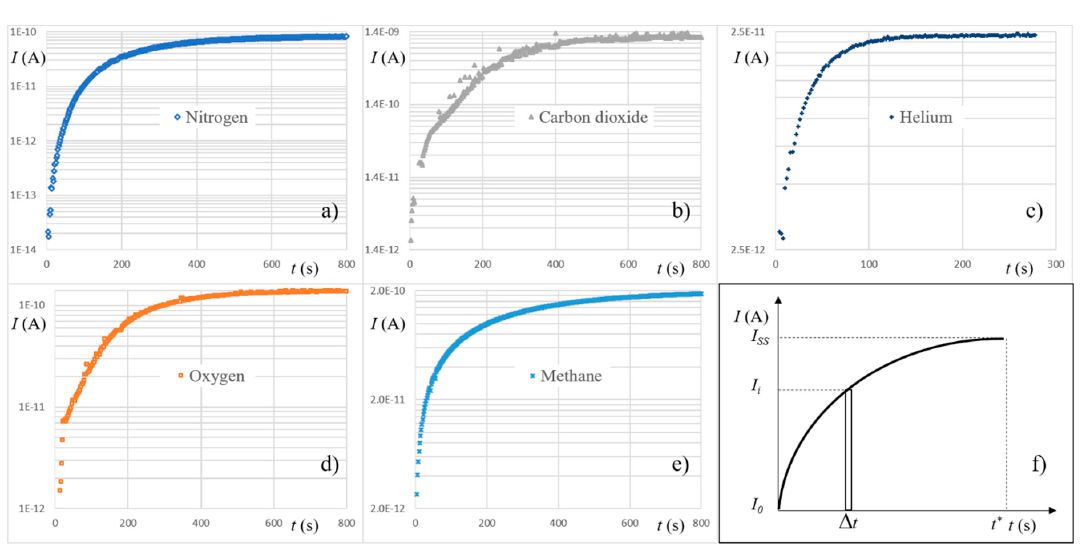
Figure 2. Diffusivity measurements. ( a – e ) Ion currents vs time of the tracer gases after filling the upstream chamber a t = 0 ( p u = 10 5 Pa); ( f ) representation of the parameters of Equation (10); in our case Δ t = 2 s.